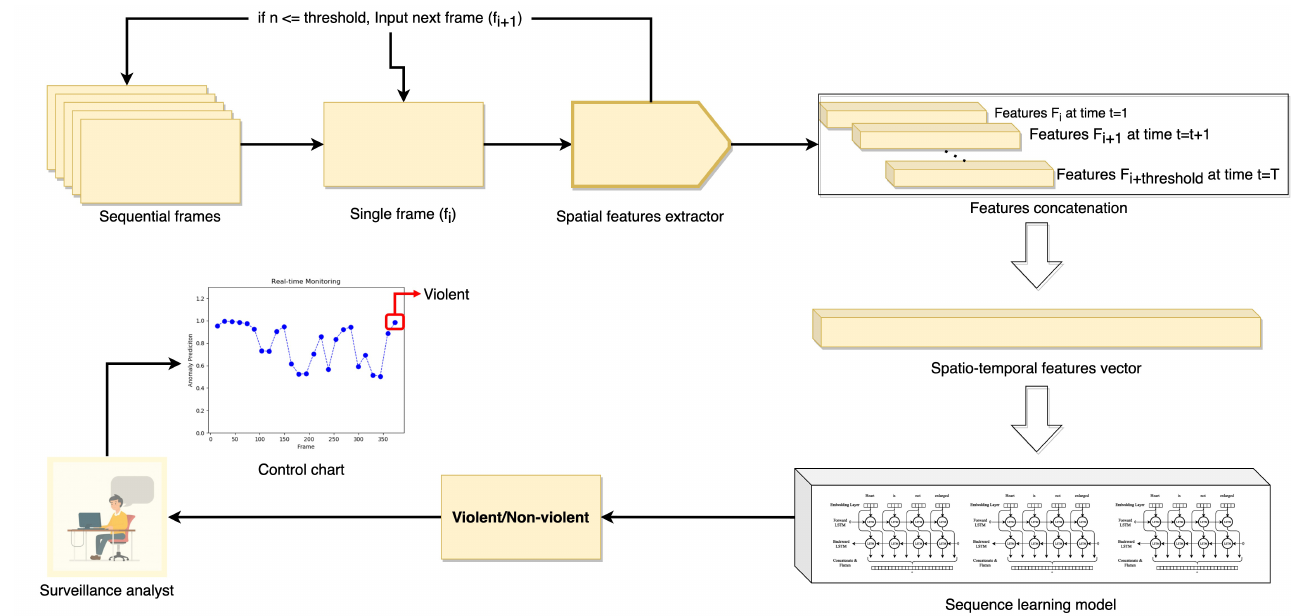
Figure 1. The proposed deep multi-scale features fusion attention-based network for violence